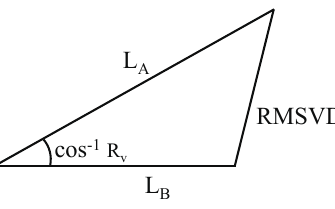
Figure 4. Geometric relationship among the vector similarity coef- ficient R v , the RMS lengths L A and L B , and RMS vector difference